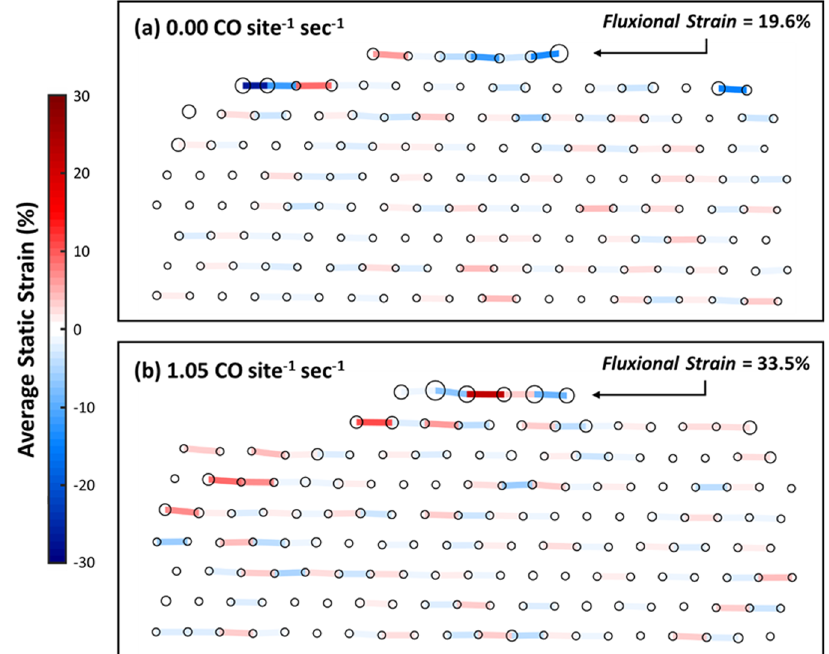
Fig. 7 Average static and fl uxional strain in CeO 2 support. a Static and fl uxional strain of Ce cation sublattice at a TOF of 0.00 CO site − 1 sec − 1 . b Static and fl uxional strain in the Ce cation sublattice at a TOF of 1.05 CO site − 1 sec − 1 . The circles signify the Ce atomic column position determined by Gaussian peak fi tting and are drawn proportional in size to the standard deviation of the fi tted Gaussian. The strain between sites is represented with a colored bar; red and blue correspond to tensile and compressive strain, respectively. The free CeO 2 (111) surface terrace between the supported Pt nanoparticles has been marked with a black arrow. (The Pt particles are not